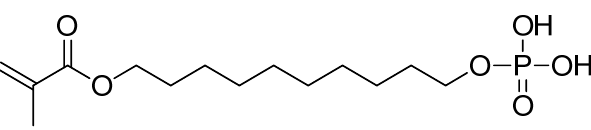
Figure 3. The chemical structure of 10-MDP.